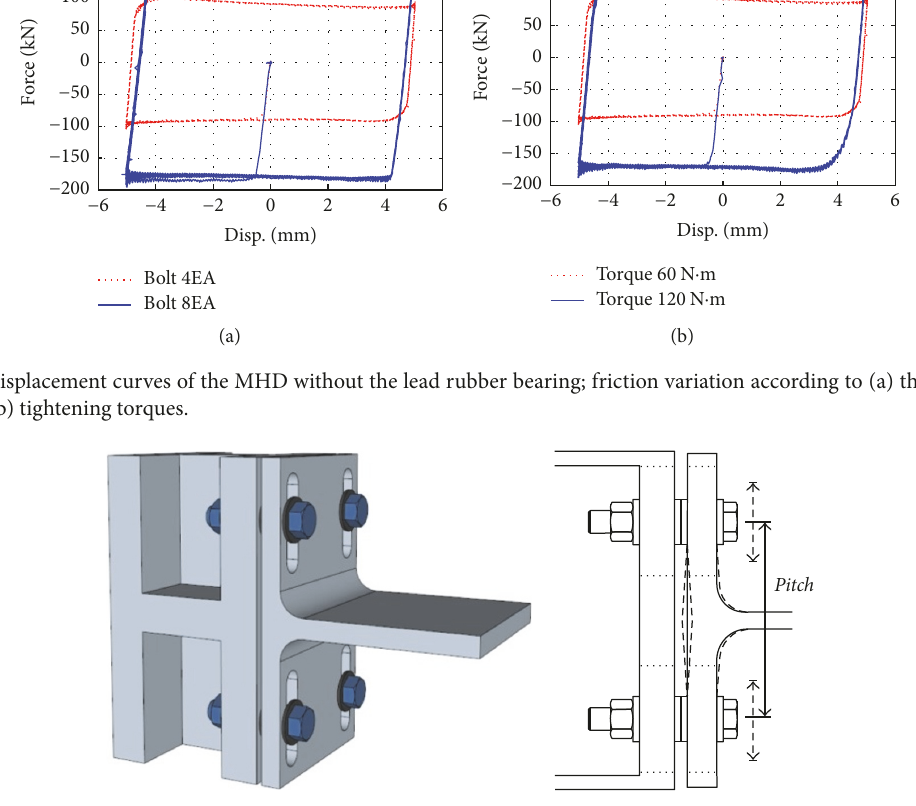
Figure 6: The bolt pitch in the T-shaped